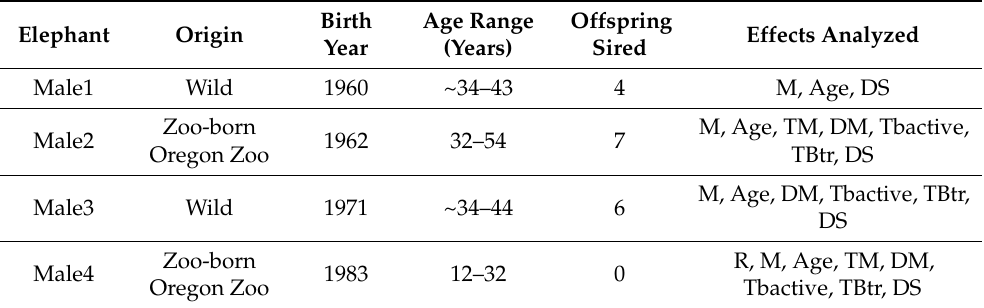
Table 1. Male elephants included in this study. Individual, origin, age range during study, whether the individual exhibited normal musth cycles, number of samples analyzed, and statistical analyses performed for each